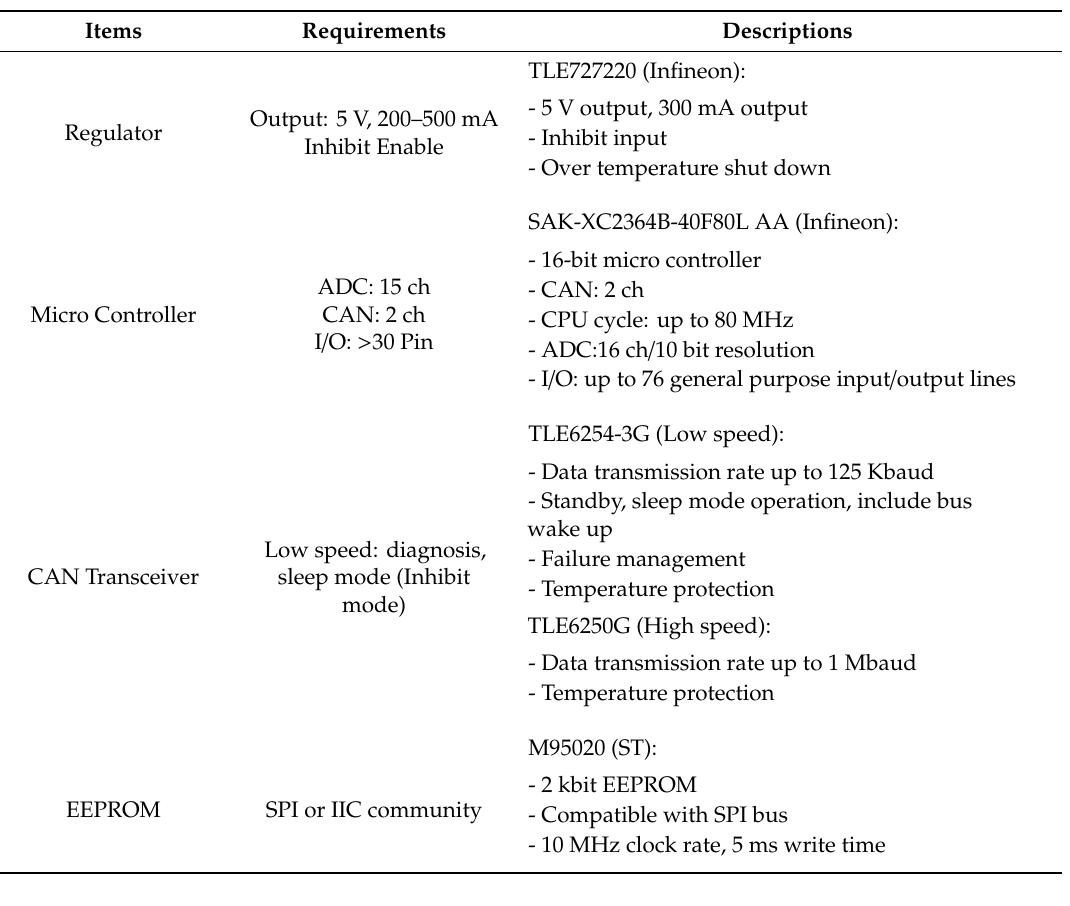
Table 1. Specifications of the main components.